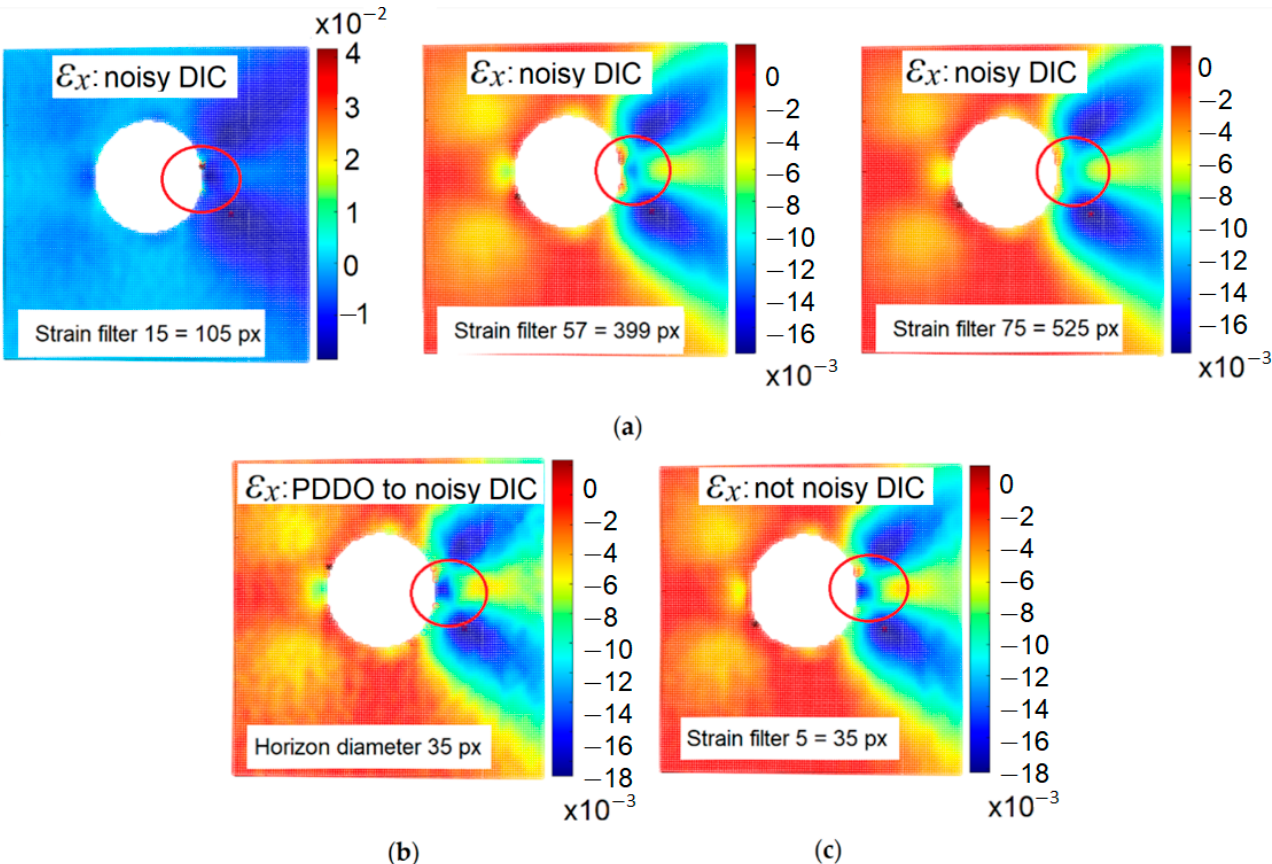
Figure 15. Strain field results: ( a ) noisy DIC; ( b ) PDDO to noisy DIC; ( c ) not noisy DIC.